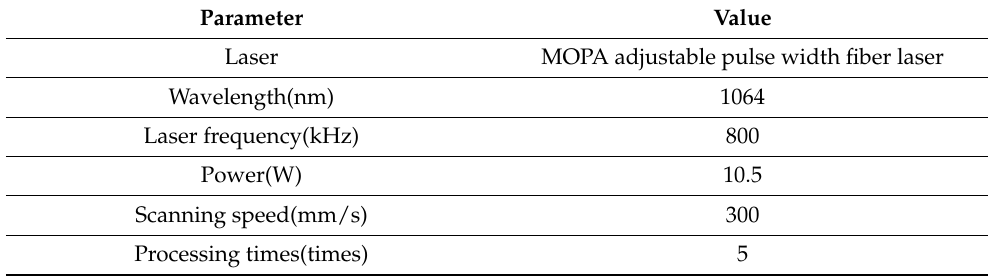
Table 1. Fiber laser marking Spraying